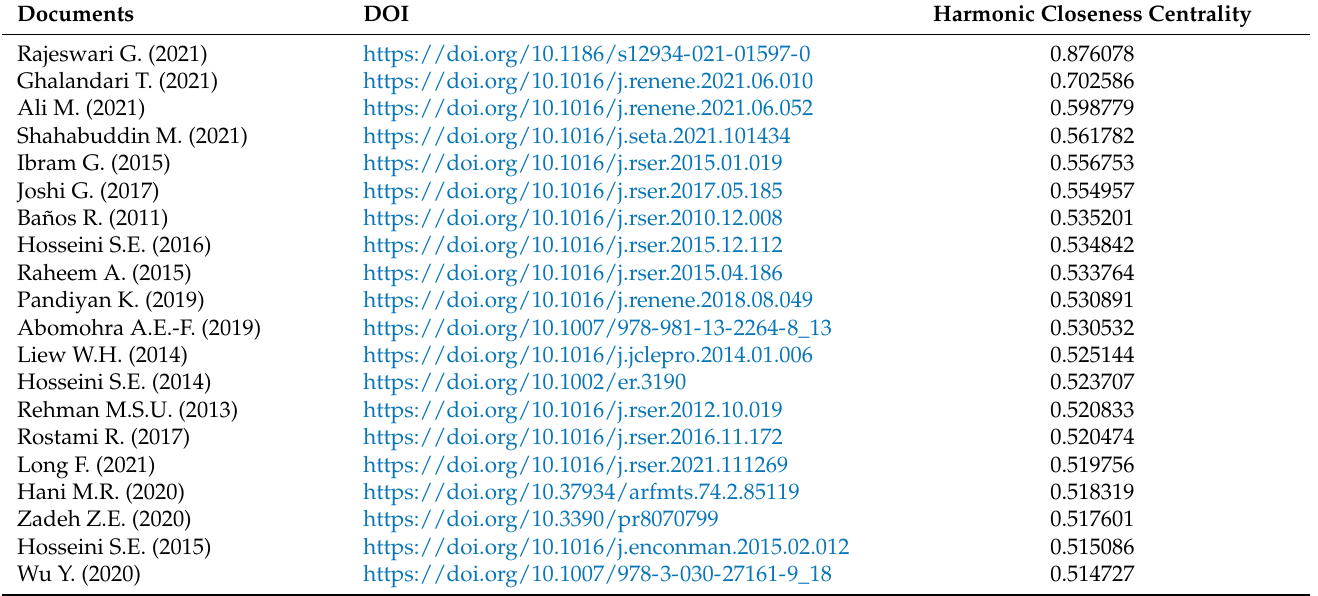
Table 5. Top-20 documents with higher harmonic closeness centrality from Scopus database for bibliographic coupling